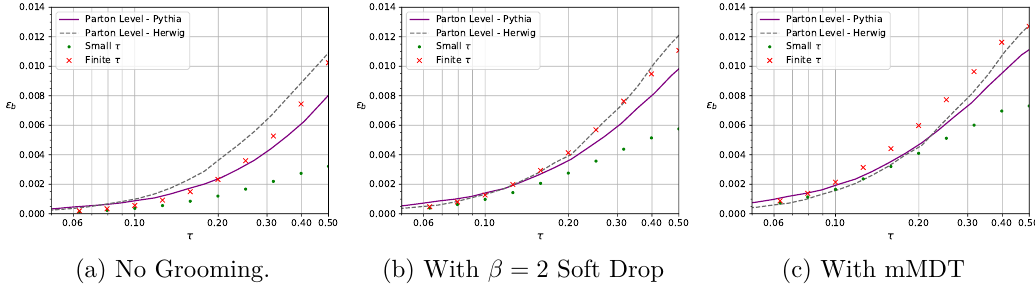
Figure 4. A comparison of our calculation for background tagging rate against parton show Monte Carlo simulations for no grooming, grooming with Soft Drop β = 2 , and grooming with mMDT. on our calculation: no grooming, Soft Drop with β = 2 pre grooming, and pre-grooming with